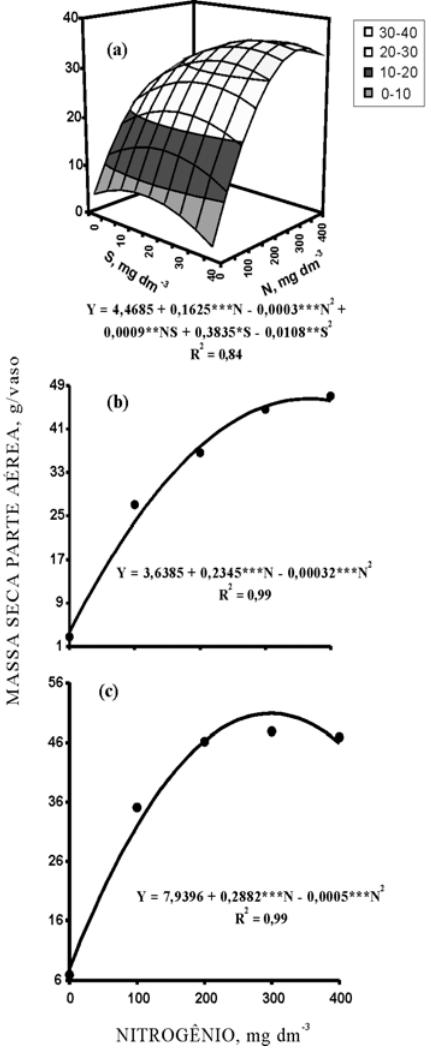
Figura 3. Produção de massa seca da parte aérea do capim-braquiária no primeiro crescimento (a), de acordo com a adubação com doses de nitrogênio e enxofre, e no segundo e terceiro crescimentos (b e c), considerando a adubação com doses de nitrogênio. *** ; ** e * Significativo a 0,1; 1 e 5 %,